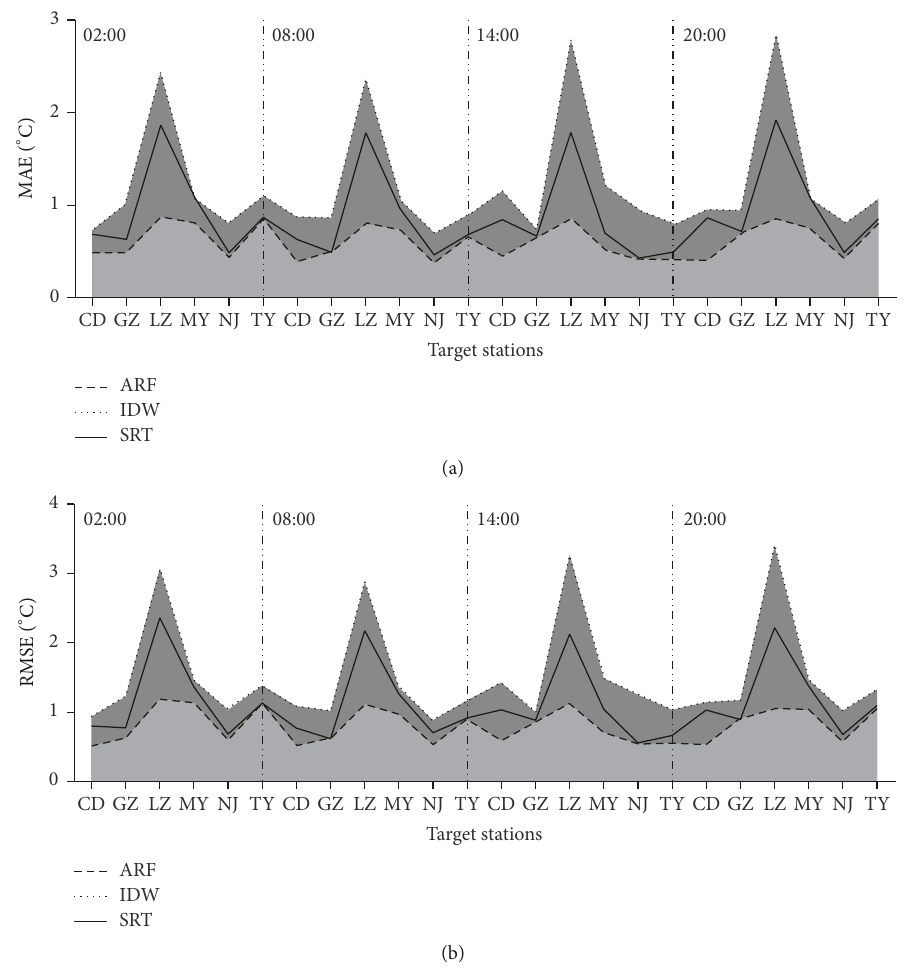
Figure 7: Comparisons of performance of the ARF, IDW, and SRT methods for different target stations: (a) the contrast condition of MAE at 02:00, 08:00, 14:00, and 20:00; (b) the contrast condition of RMSE at 02:00, 08:00, 14:00, and